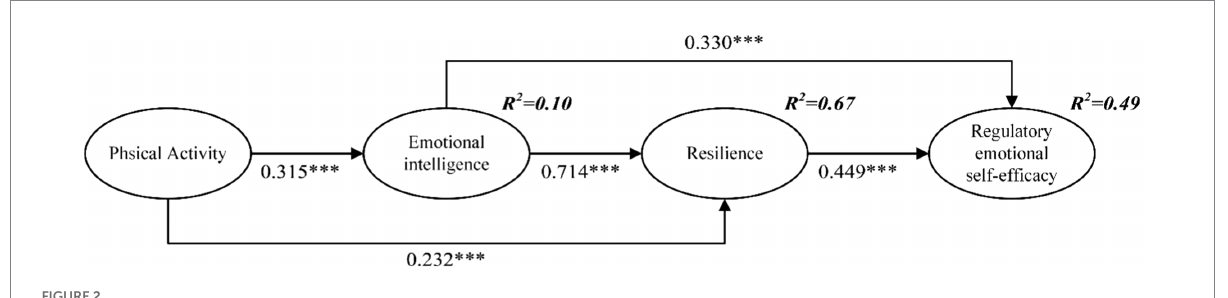
FIGURE 2 Structural path model. *** p < 0.001. Standardized coefficients are reported.